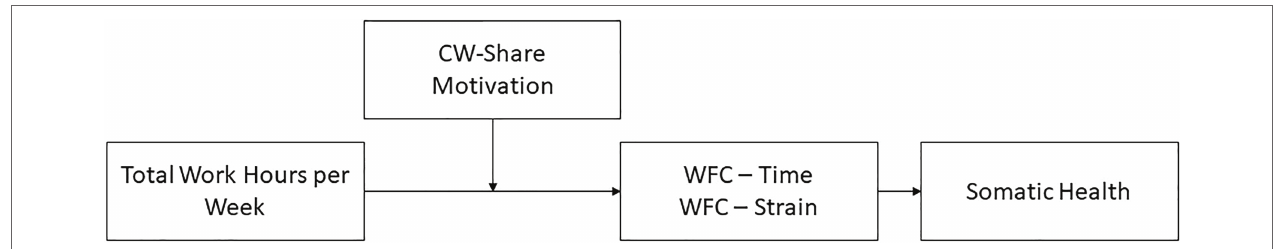
FIGURE 1 | Model of Crowdworker General Somatic Health. WLC-time/ − strain = time-based and strain-based work-life conflict, CW-Share = Share of crowdwork in total work hours; Motivation = primary motivation to earn money through